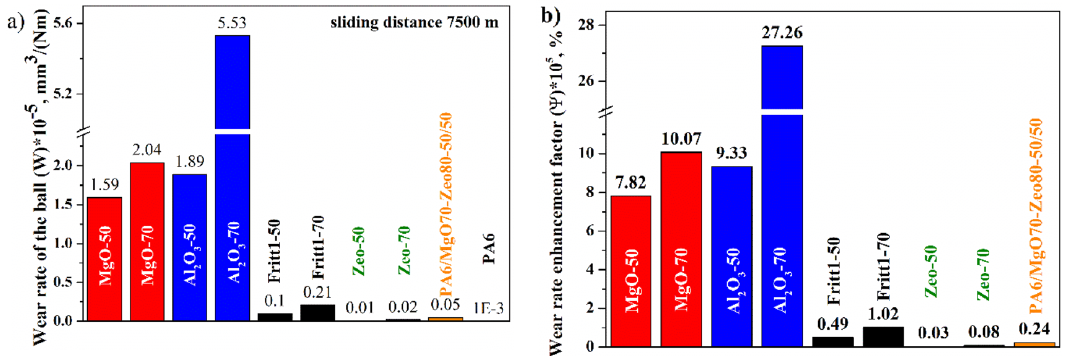
Figure 10. Specific wear rate with different types of fillers and filler content ( a ) and specific wear rate enhancement factor ( b